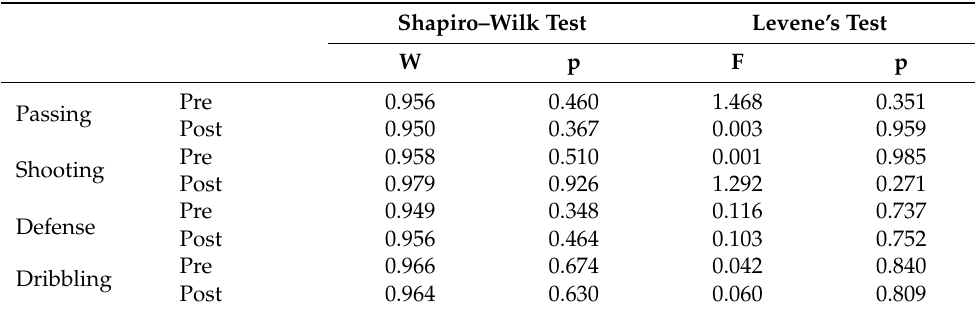
Table 2. Normality and homogeneity of variance values for dependent variables assessed by the basketball skill test.